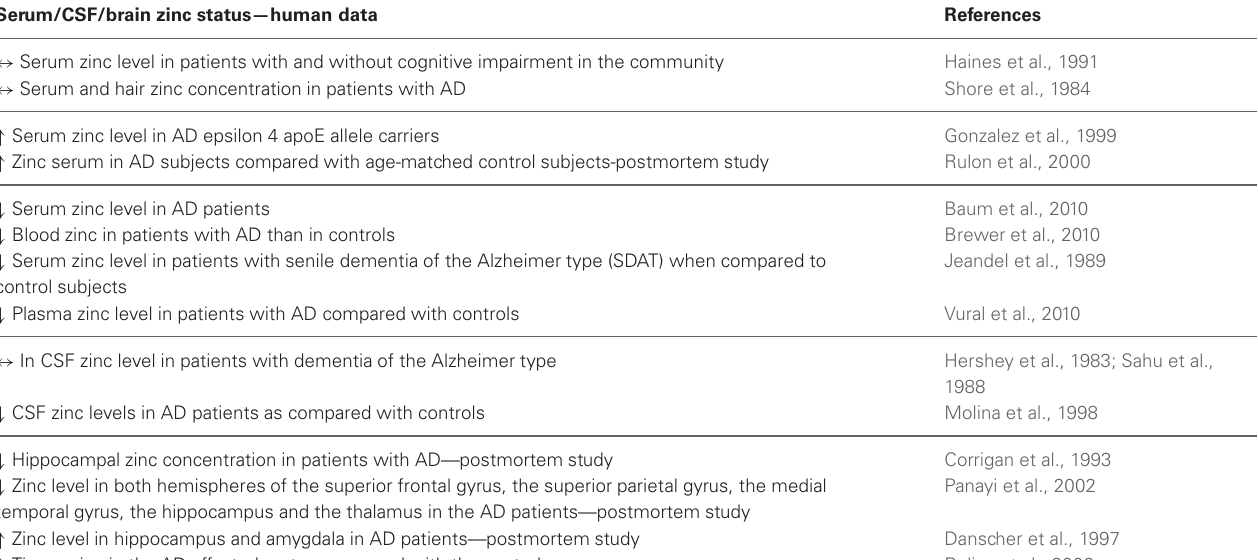
Table 2 | Summary of the main clinical and preclinical findings supporting the involvement of zinc in